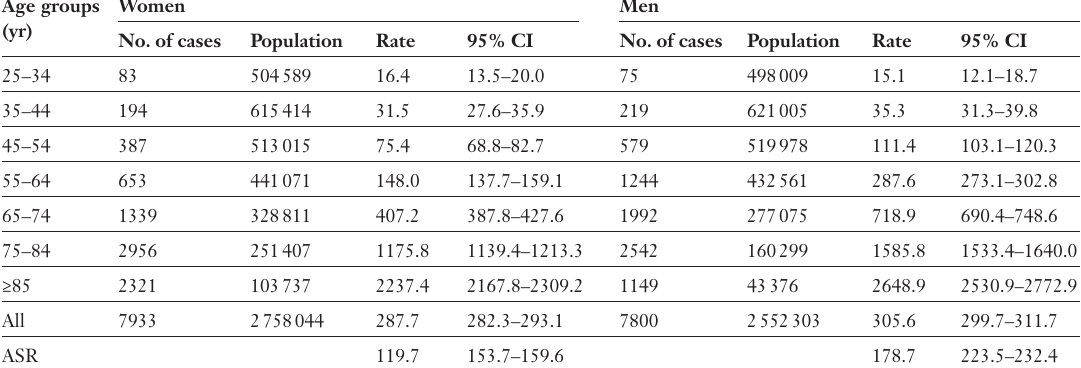
Table 2 Age-specific number of deaths due to stroke, and stroke mortality rates per 100000 population (Switzerland